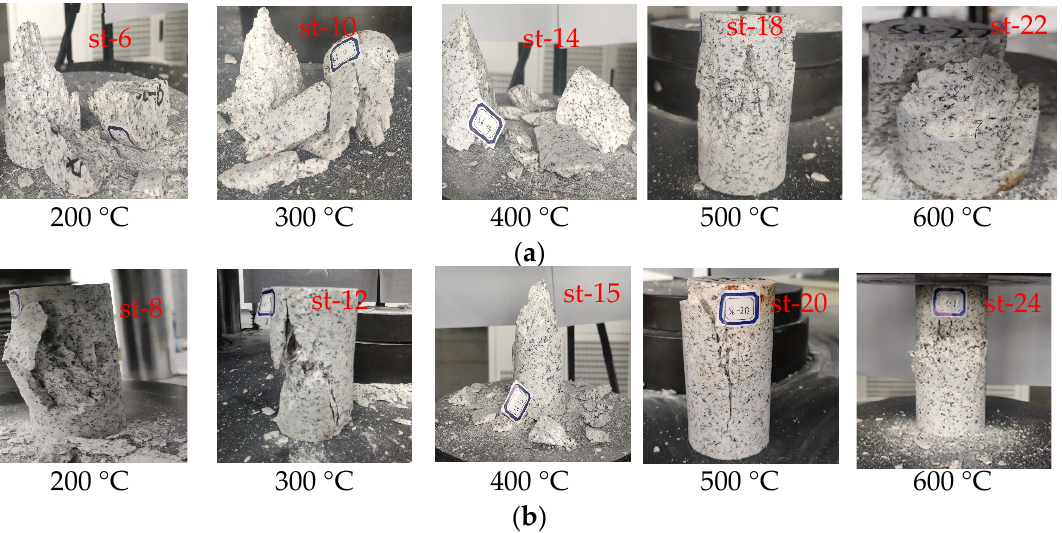
Figure 11. Failure modes of granite with different cooling modes. ( a ) Failure modes of granite under natural cooling; ( b ) Failure modes of granite under cooling in water.